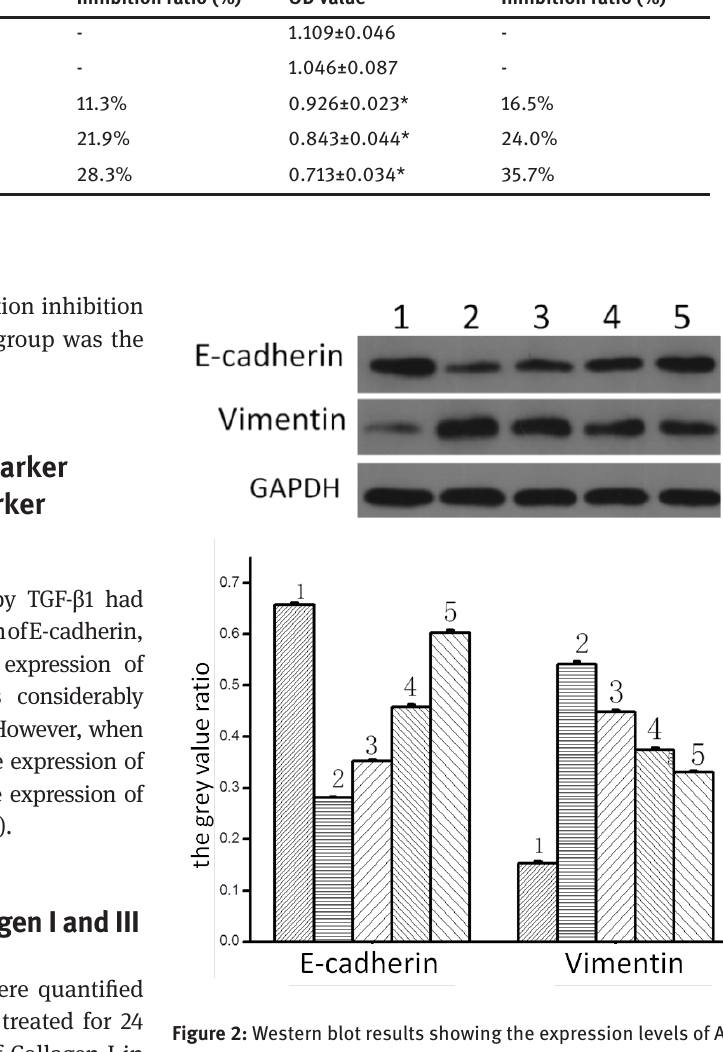
Figure 2: Western blot results showing the expression levels of A549 cells treated with different concentrations of GLXB-D drug serum and TGF-β1 for 24 h . (A): The protein expression straps of E-cadherin and Vimentin; (B): The grey value ratio of expressions of E-cadherin and Vimentin. (1) control group; (2) 5ng/mL TGF-β1 induced group; (3) 5% GLXB-D drug serum group; (4) 10% GLXB-D drug serum group; (5) 15% GLXB-D drug serum